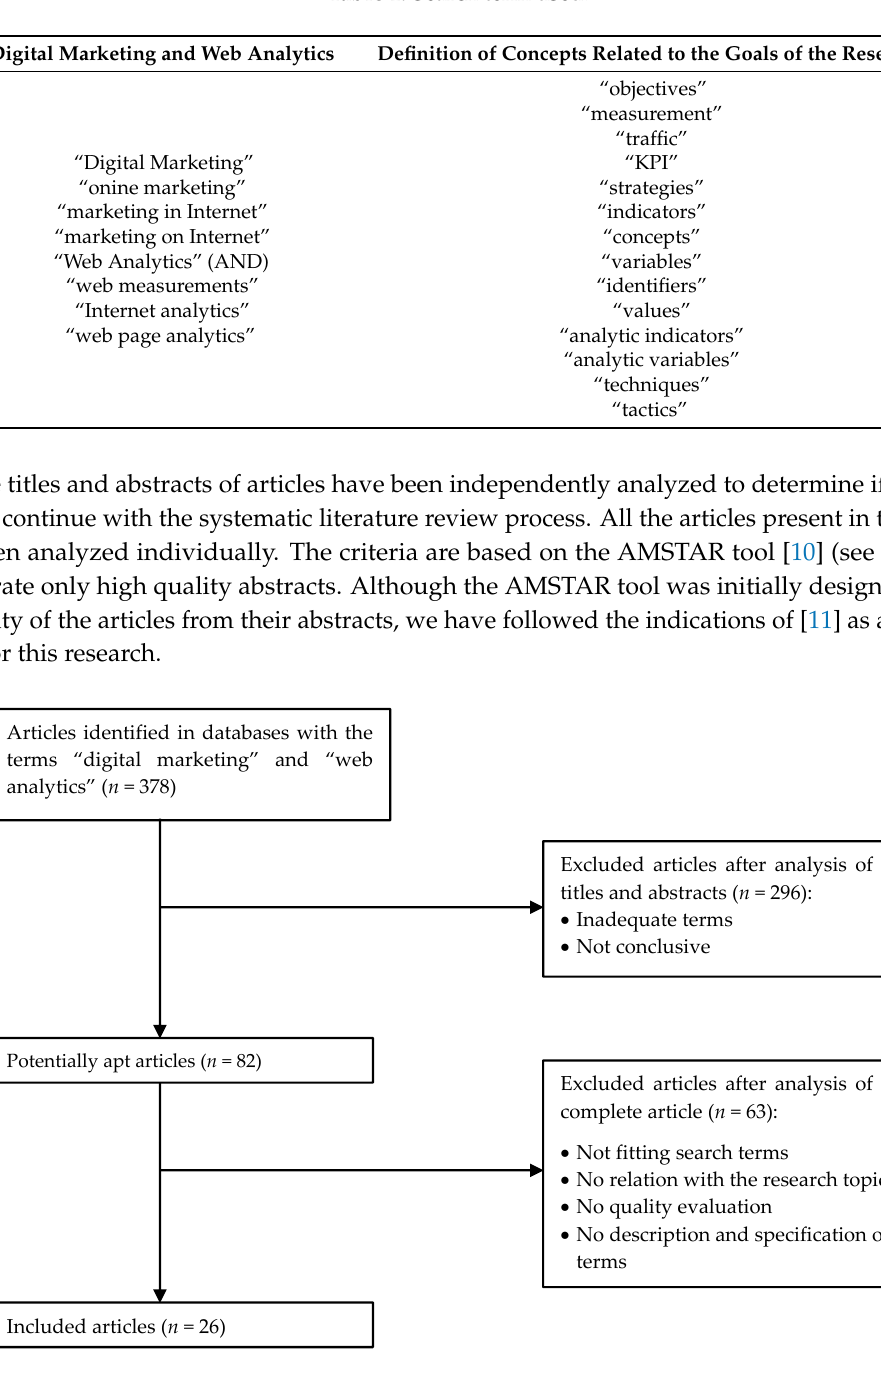
Figure 1. PRISMA 2009 Flow Diagram .